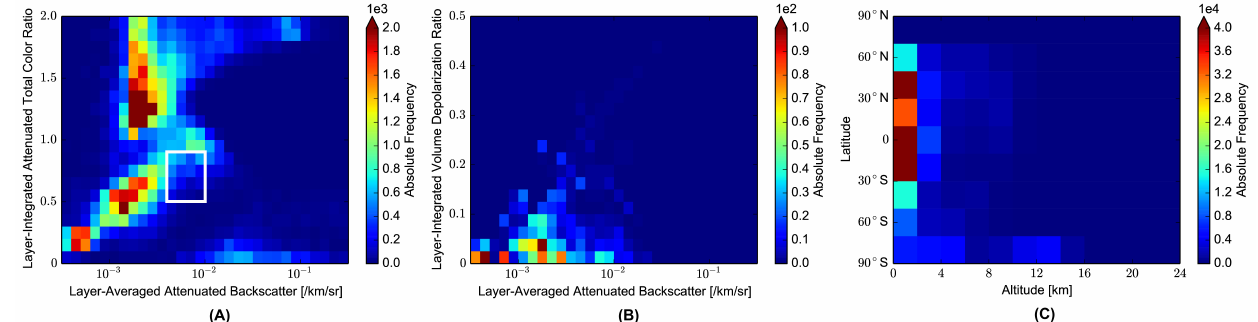
Figure 5. Occurrence frequencies of NCR features with filters applied in the 2D space of dimensions CR-AB ( A ); DR-AB ( B ); and latitude–altitude ( C